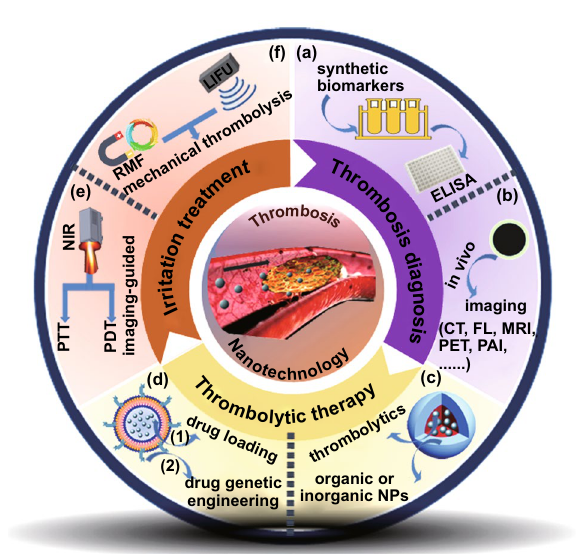
Fig. 1 Scheme illustration of nano-medicine-based thrombosis diag- nosis and